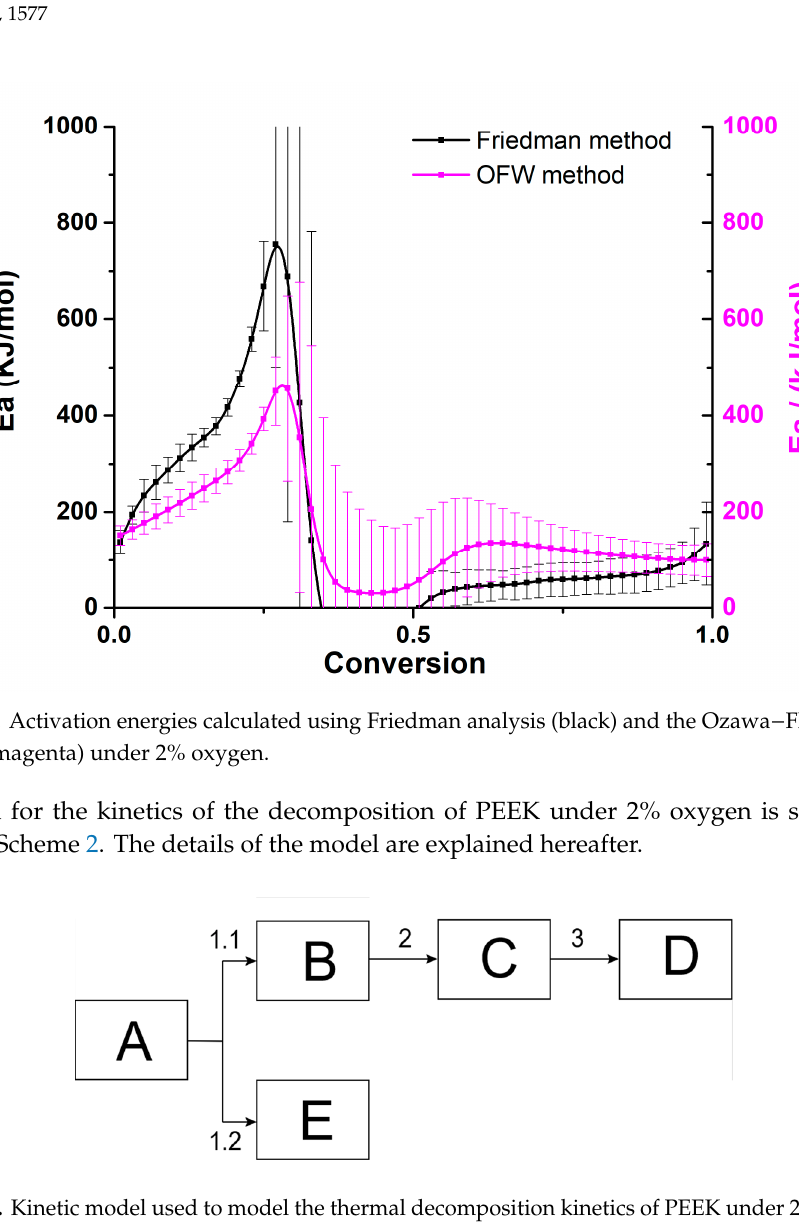
Scheme 2. Kinetic model used to model the thermal decomposition kinetics of PEEK under 2% oxygen.